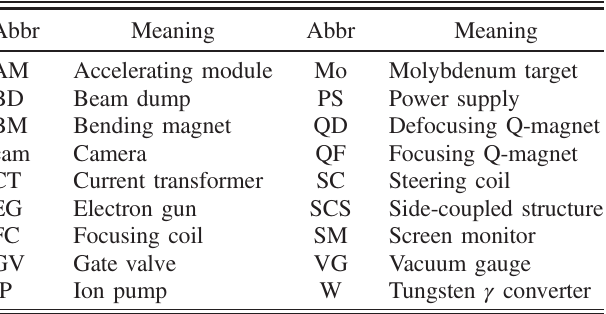
TABLE I. List of abbreviations (Abbr) used in Fig.